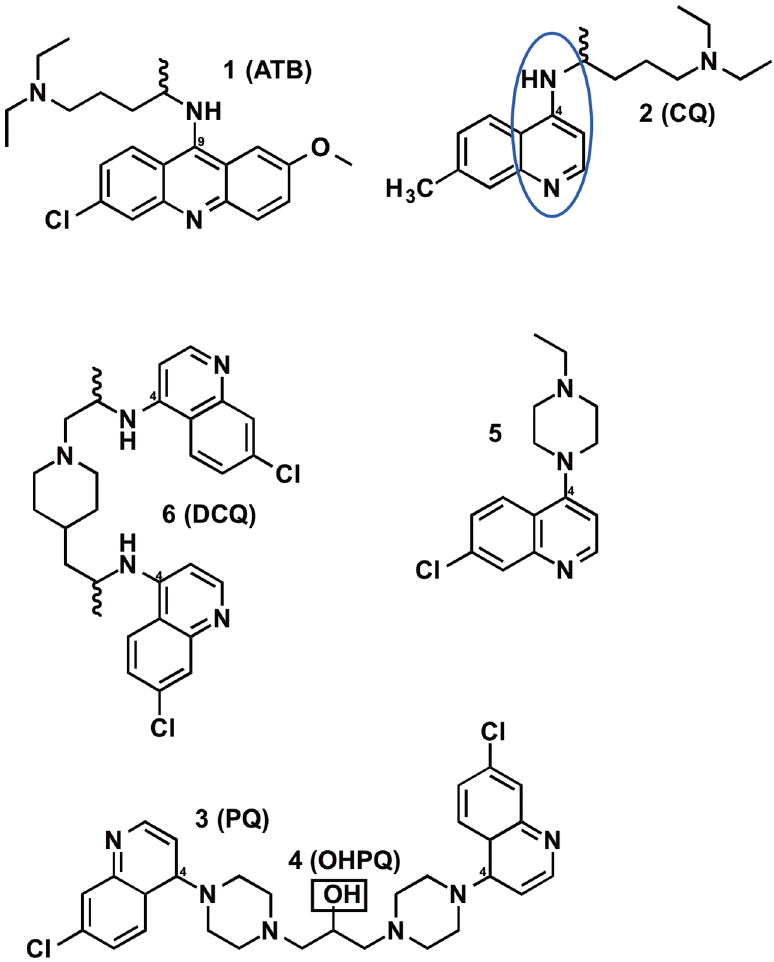
Fig 1. Structures of the main p AP compounds examined. Note outline (blue) of the p -aminopyridine moiety in CQ(2) and its presence in Atebrin, ATB(1) and (5). Also note 2 p AP moieties in each of (3), (4)